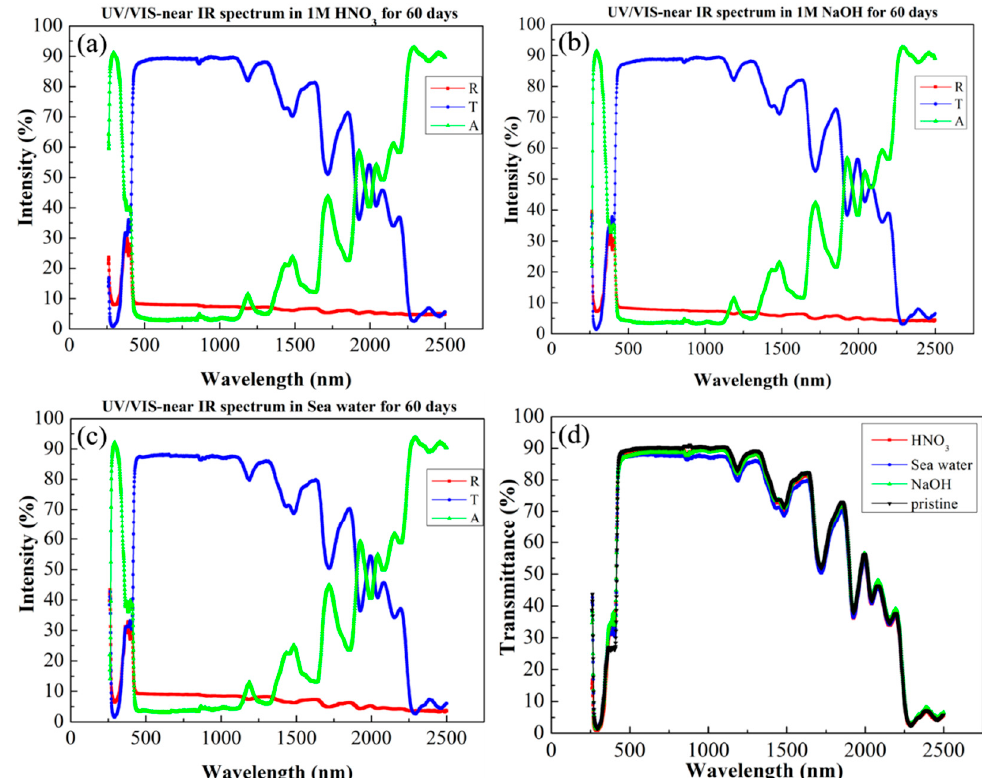
Figure 7. UV–vis–near-IR spectra of printed materials in ( a ) 1 M nitric acid aqueous solution, ( b ) 1 M sodium hydroxide aqueous solution, and ( c ) sea water (3.5% salt solution). ( d ) Transmittance spectra obtained after exposure to different extreme environments for three months.